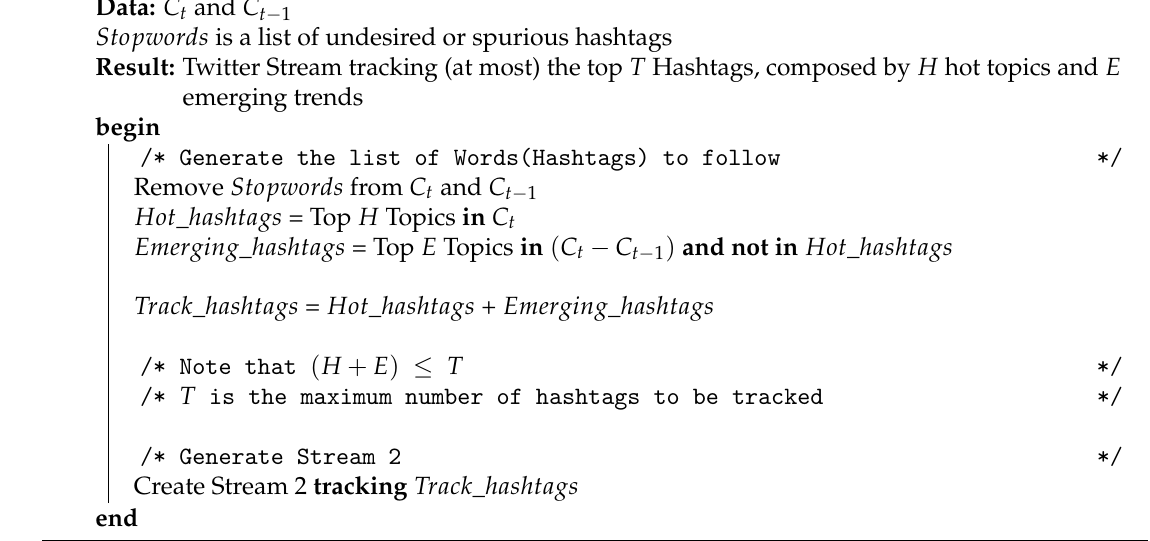
Algorithm 2: Tweet